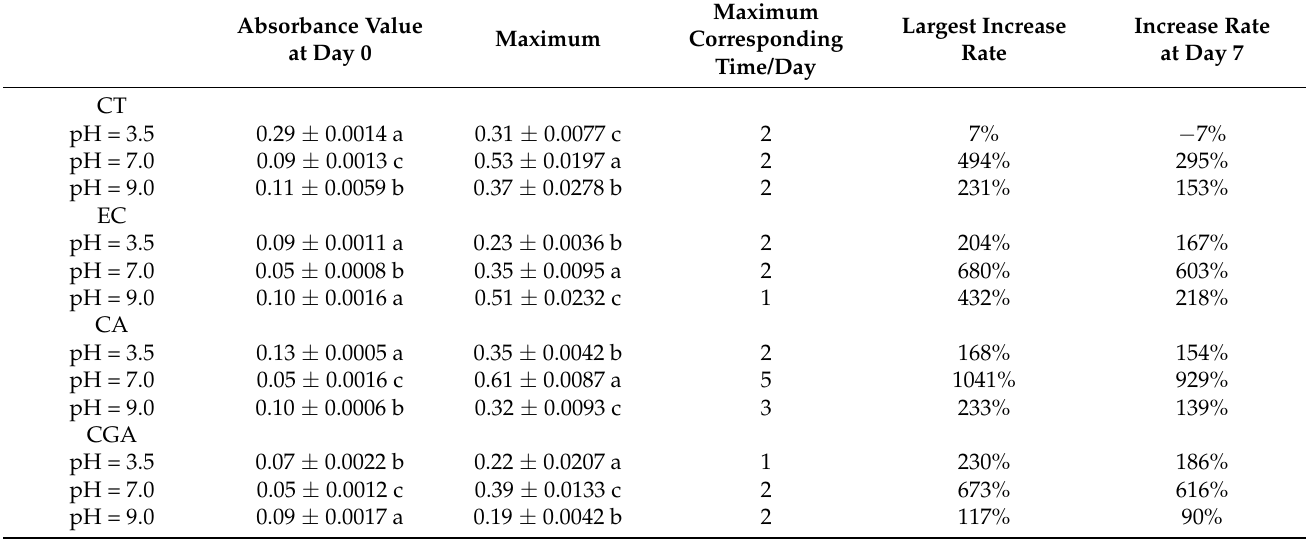
Table 1. Reducing power (Absorbance Value at 700 nm) of autoxidation products (different